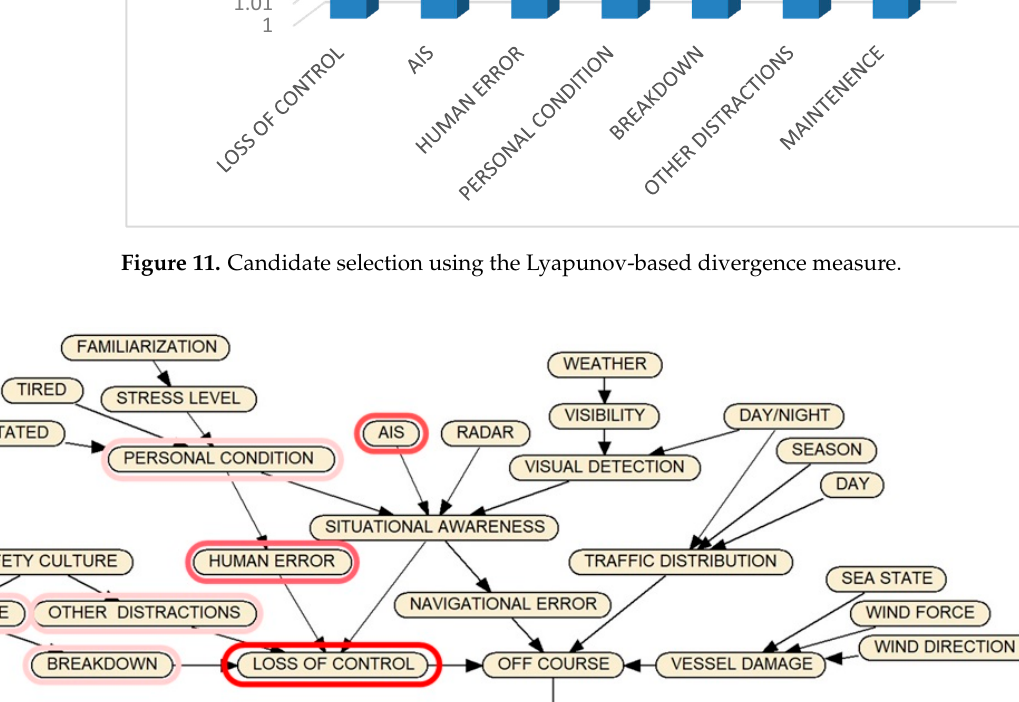
Figure 12. Visualization of the accident-contributing candidates for “Zlatni Zal”.